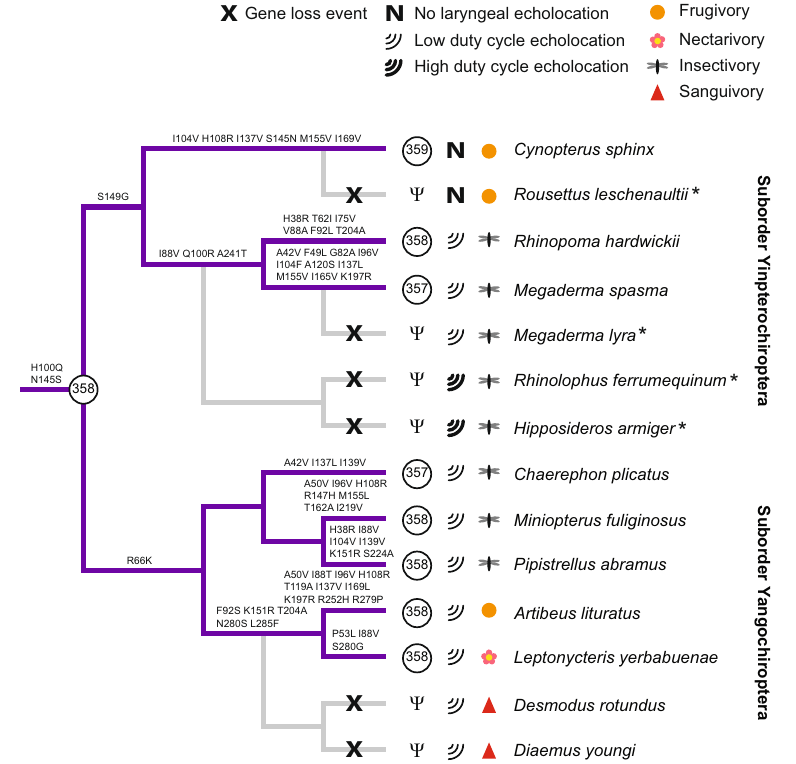
Figure 3. Evolution of UV pigments in bats. λ max values of the UV pigments, type of echolocation, and diet are mapped onto the chiropteran phylogenetic tree. Absence of SWS1 (pseudogene) is indicate by Ψ . Amino- acid substitutions in the SWS1 opsins are indicated on the lineages, with only sites between transmembrane I and VII shown 44 . Numbering of the sites follows that of bovine rhodopsin. Losses of SWS1 genes in bats are indicated by gray branches in the tree. Gene loss events which have been published in previous studies are denoted by “ * ” after the species name 11,20